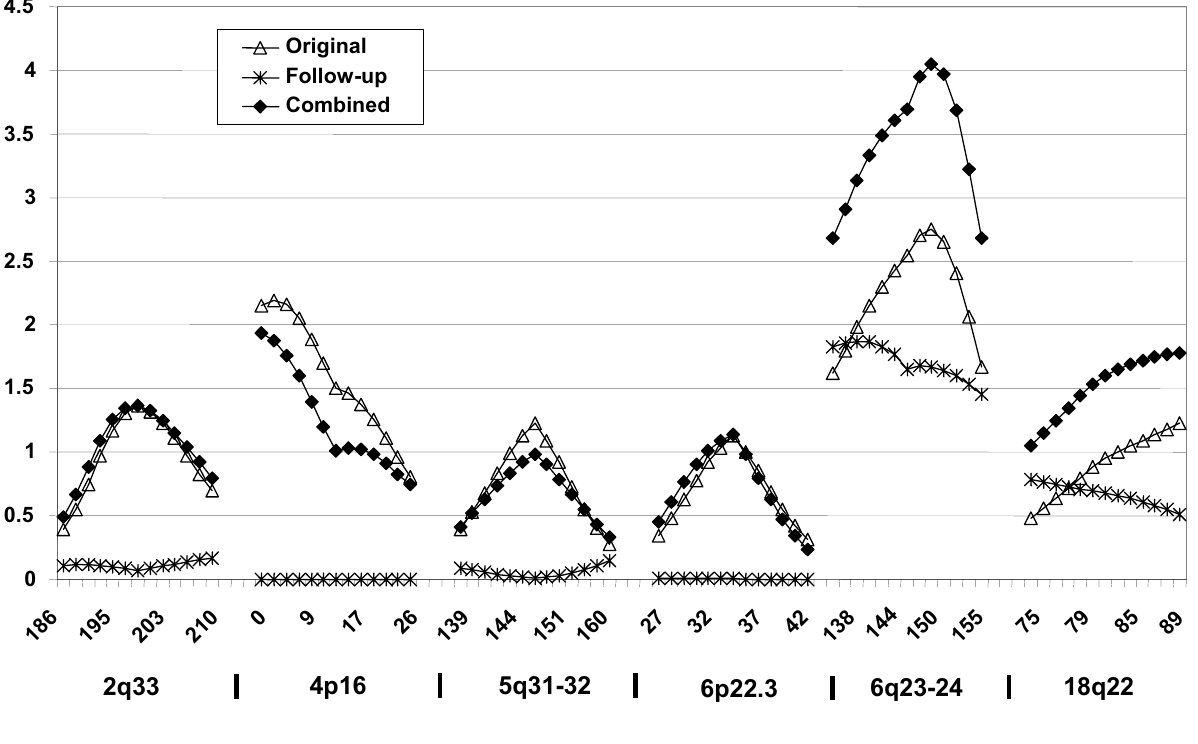
Figure 1 Multipoint linkage results generated by MERLIN across six chromosome regions in followup study. The x-axis indicates genetic distance and the y-axis indicates LOD score. These data show the confirmed evidence for linkage to 6q23-24 using Model One age at onset